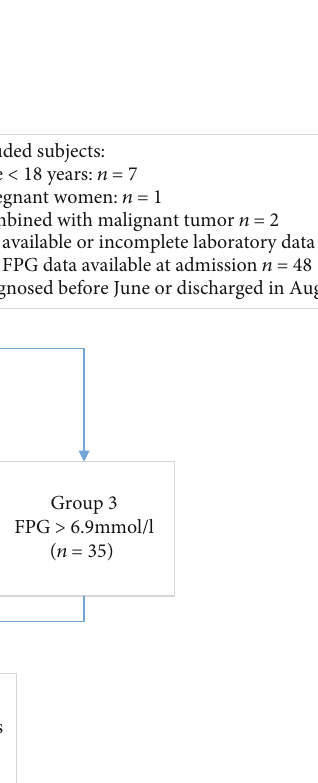
Figure 1: Flow diagram of patient